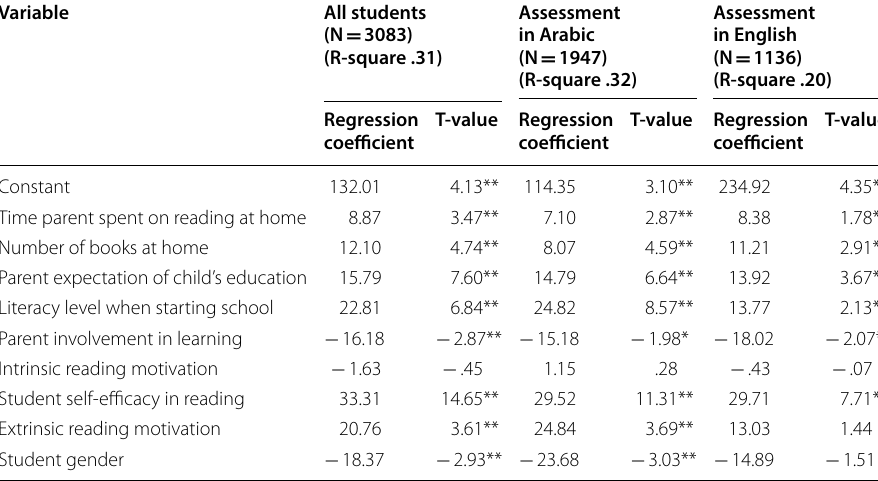
** Significant at .01; * Significant at .05